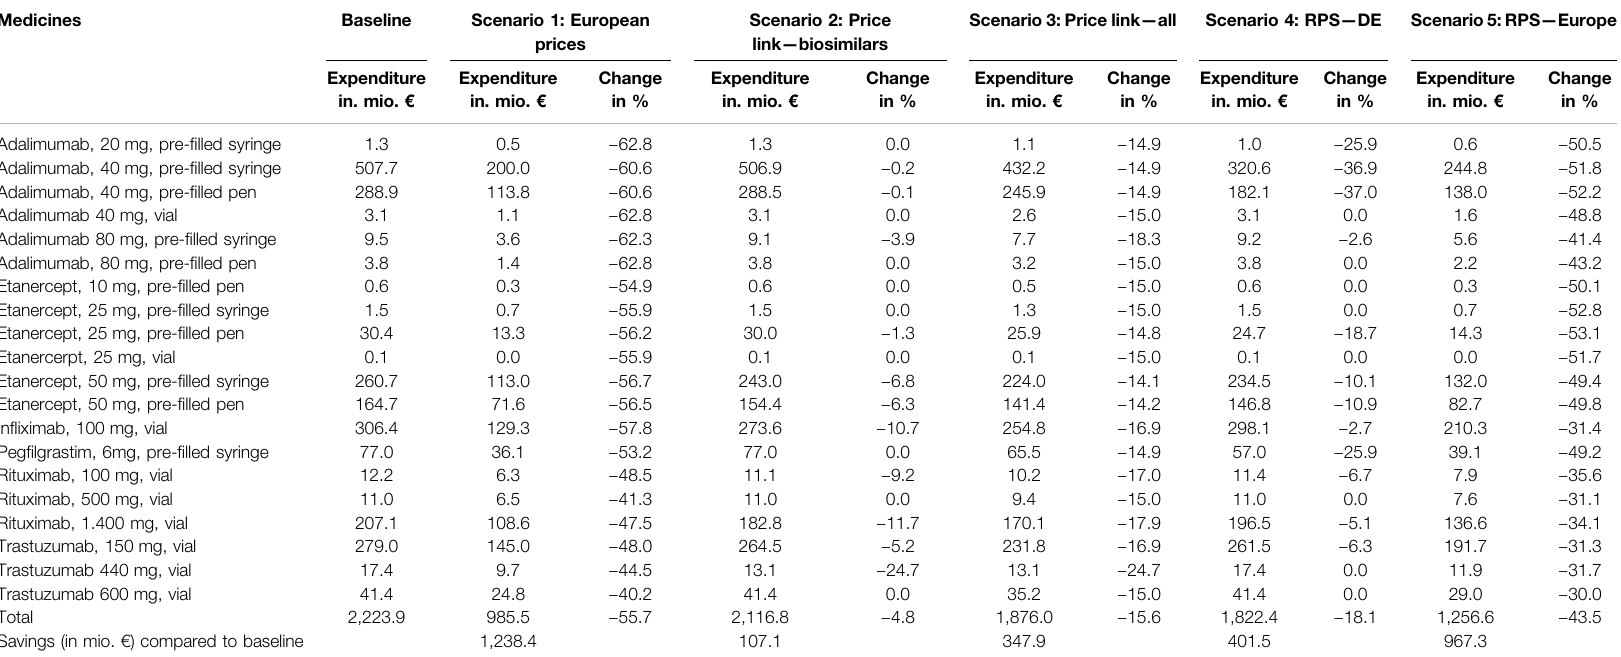
TABLE 6 | Overview of potential expenditure and savings (in %) for 2018 based on the fi ve scenarios, broken down by product. Medicines